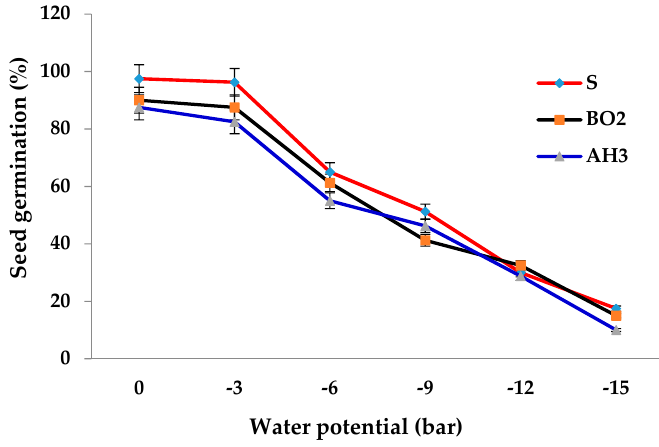
Figure 2. Final germination of the HF (S) (red bars), BO2 (Ile-1781-Leu) (black bars), and AH3 (Ile-2041-Asn) (blue bars) Lolium rigidum populations under water stress. The corresponding equations are: population S: y = − 17.404 + 0.166 x , std. error: 0.983, ( r 2 = 0.97); population BO2 (Ile-1781-Leu): y = − 17.436 + 0.182 x , Std.Error: 0.966, ( r 2 = 0.97); population R2 (Ile-2041-Asn): y = − 17.024 + 0.184 x , std. error: 0.795, ( r 2 = 0.98).